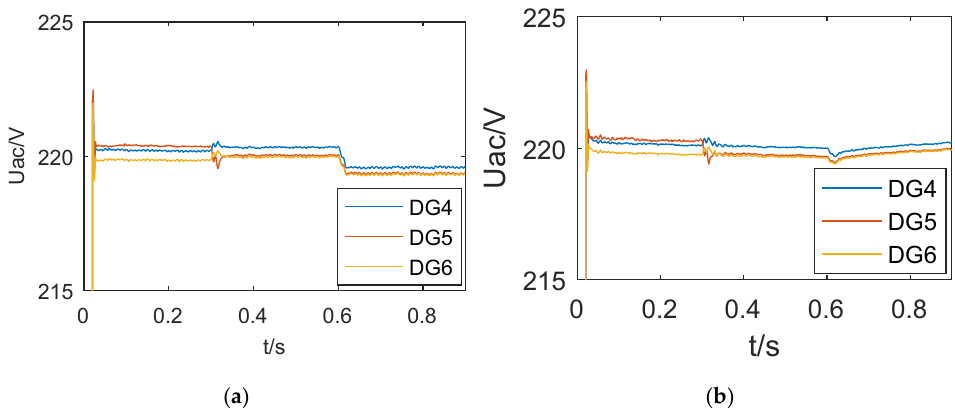
Figure 8. Voltage of each node of AC subnet. ( a ) Voltage of each node of AC subnet under traditional droop control. ( b ) Voltage of each node of AC subnet based on OPPRA.